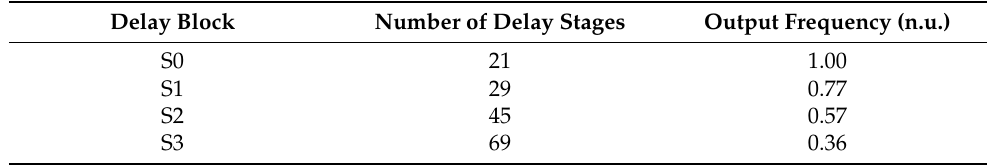
Table 2. NAND-based programmable RO simulation results. Delay Block